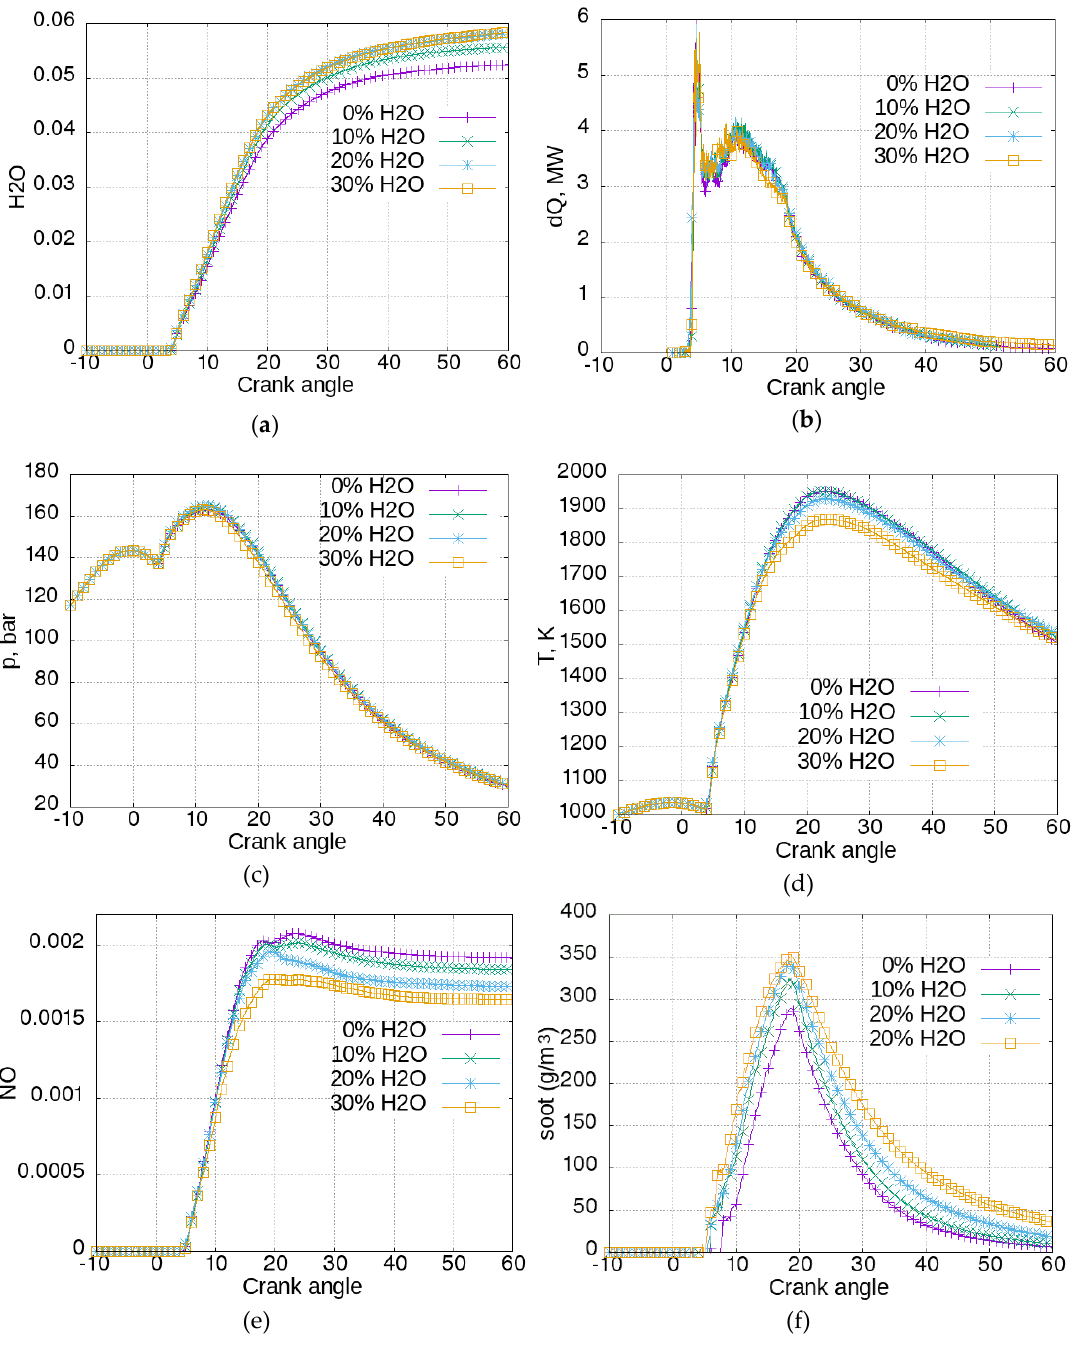
Figure 5. The influence of fuel-water emulsion injection on the main combustion parameters: ( a ) Water vapor concentration; ( b ) Rate of heat release; ( c ) Cylinder pressure; ( d ) Cylinder temperature; ( e ) NO concentration; ( f ) Soot concentration.